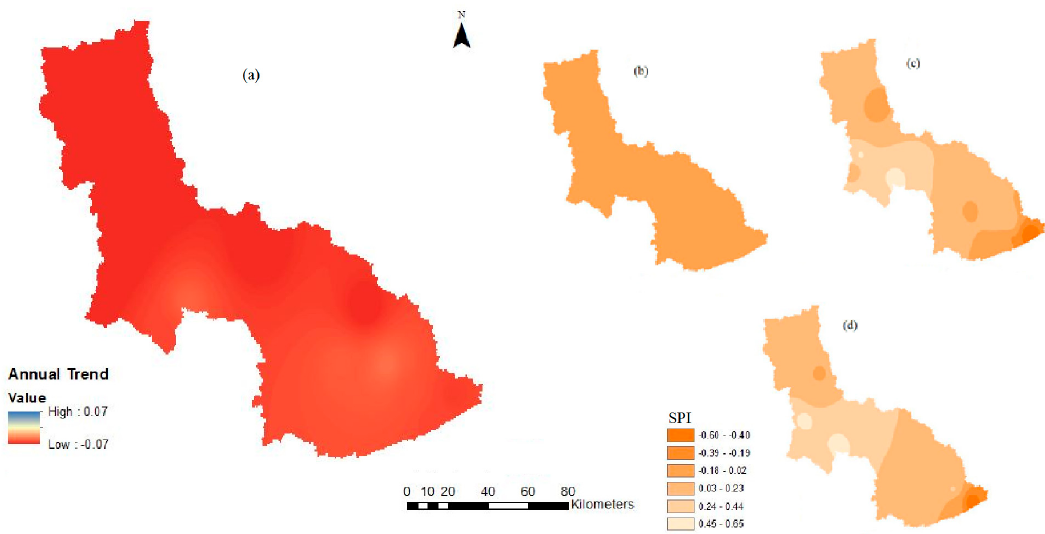
Figure 11. Spatial distribution of SPI ( a ) trend and mean values under: ( b ) baseline; ( c ) late ‐ century RCP 4.5; and ( d ) late ‐ century RCP 8.5, in the Kentucky River Basin.